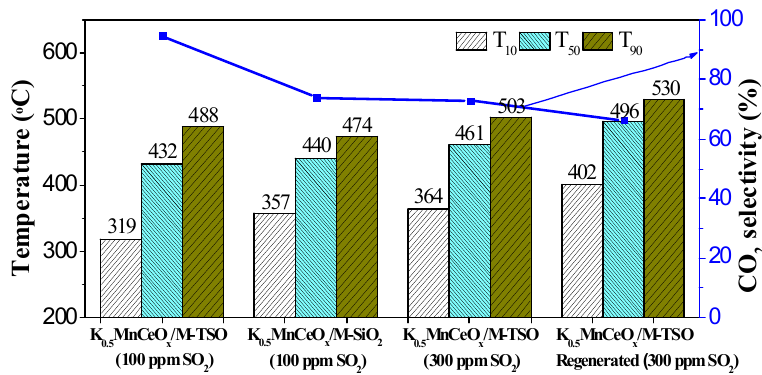
Figure 7. Catalytic performance of catalysts under 100 ppm or 300 ppm SO 2 .